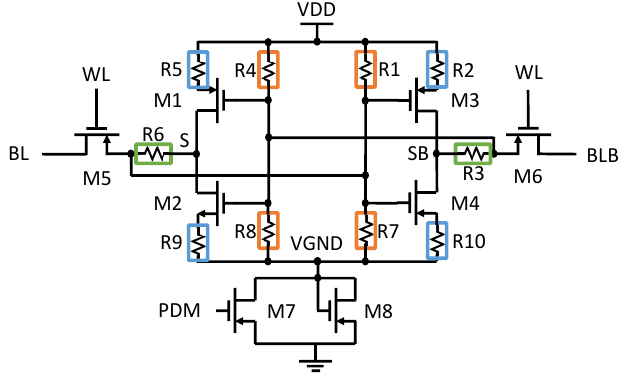
Figure 3. The resistive defects considered in this study.